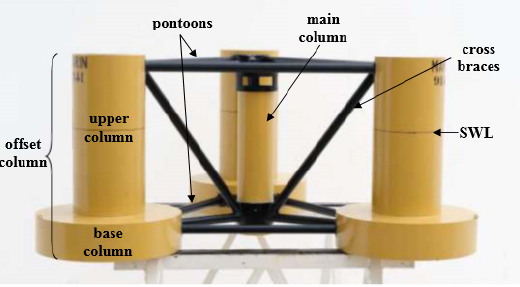
Figure 2. As-built picture of DeepCwind semi-submersible for 1/50th scale tests [2].